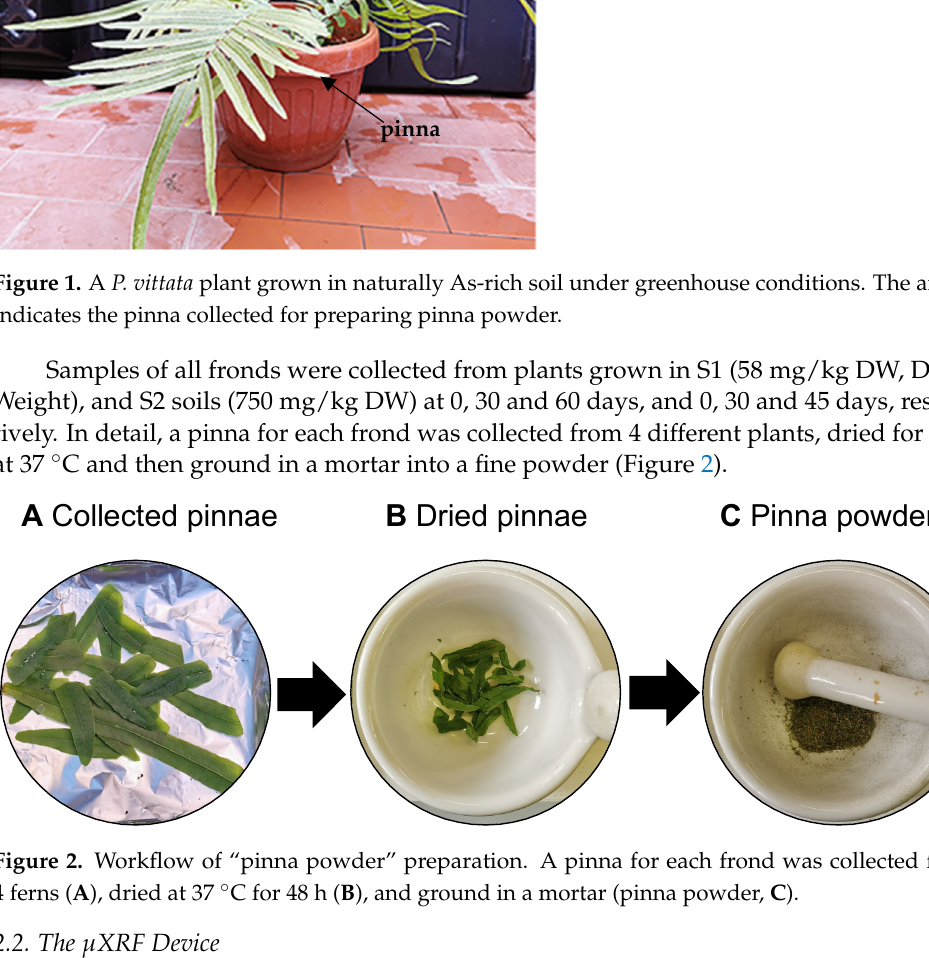
Figure 2. Workflow of “pinna powder” preparation. A pinna for each frond was collected from 4 ferns ( A ), dried at 37 °C for 48 h ( B ), and ground in a mortar (pinna powder, C ).